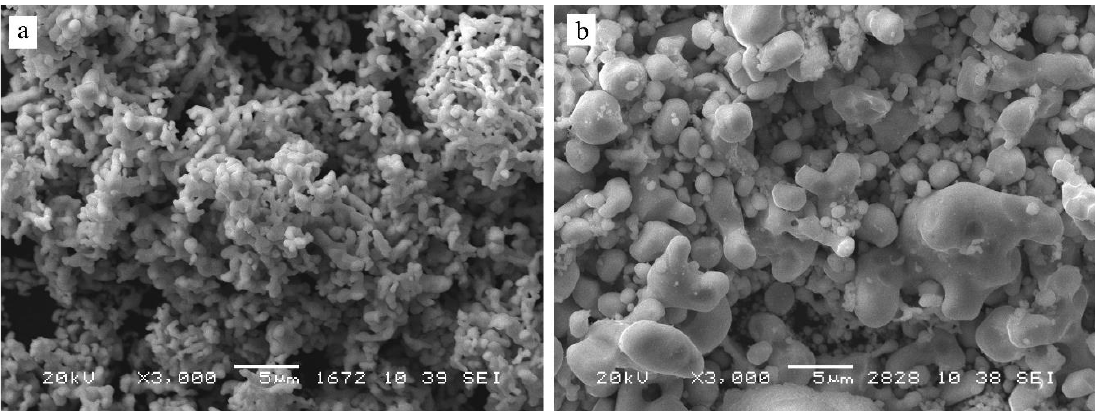
Table 2. Structural parameters and phase compositions of the initial Co and Zr powders. Figure 2. Scanning electron micrographs of the ( a ) initial Co and ( b ) initial Zr powders.